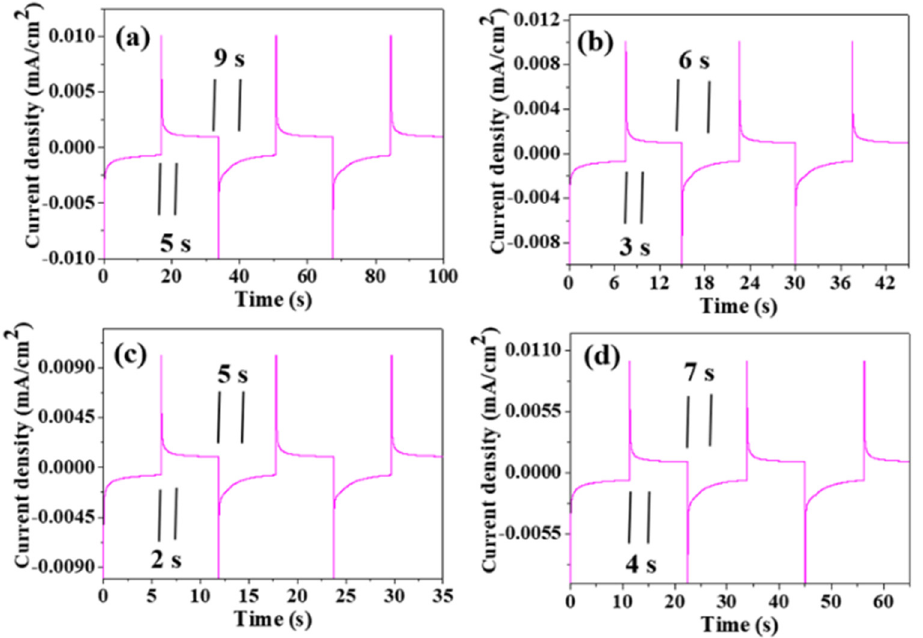
Figure 5. Response time changes of ( a ) WO 3 1 h, ( b ) WO 3 4 h, ( c ) WO 3 9 h, and ( d ) WO 3 18 h.